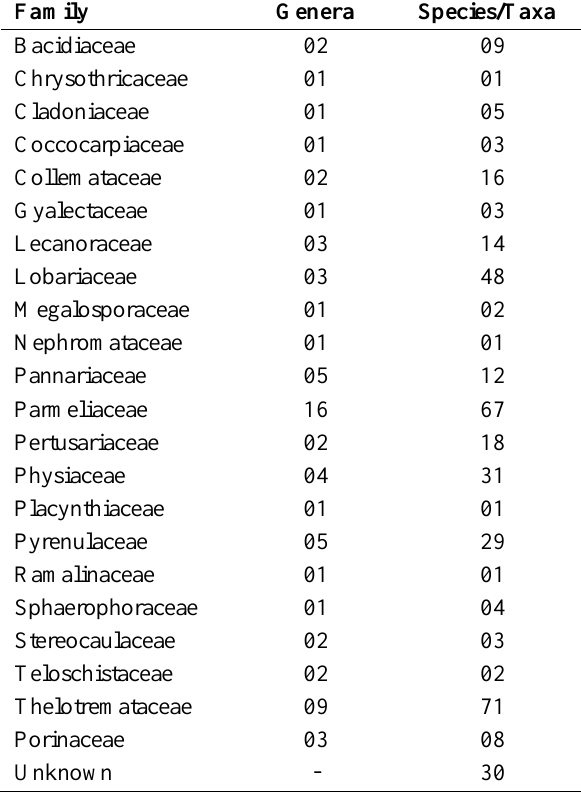
Table 4: Number of genera and taxa included in each lichen families recorded in